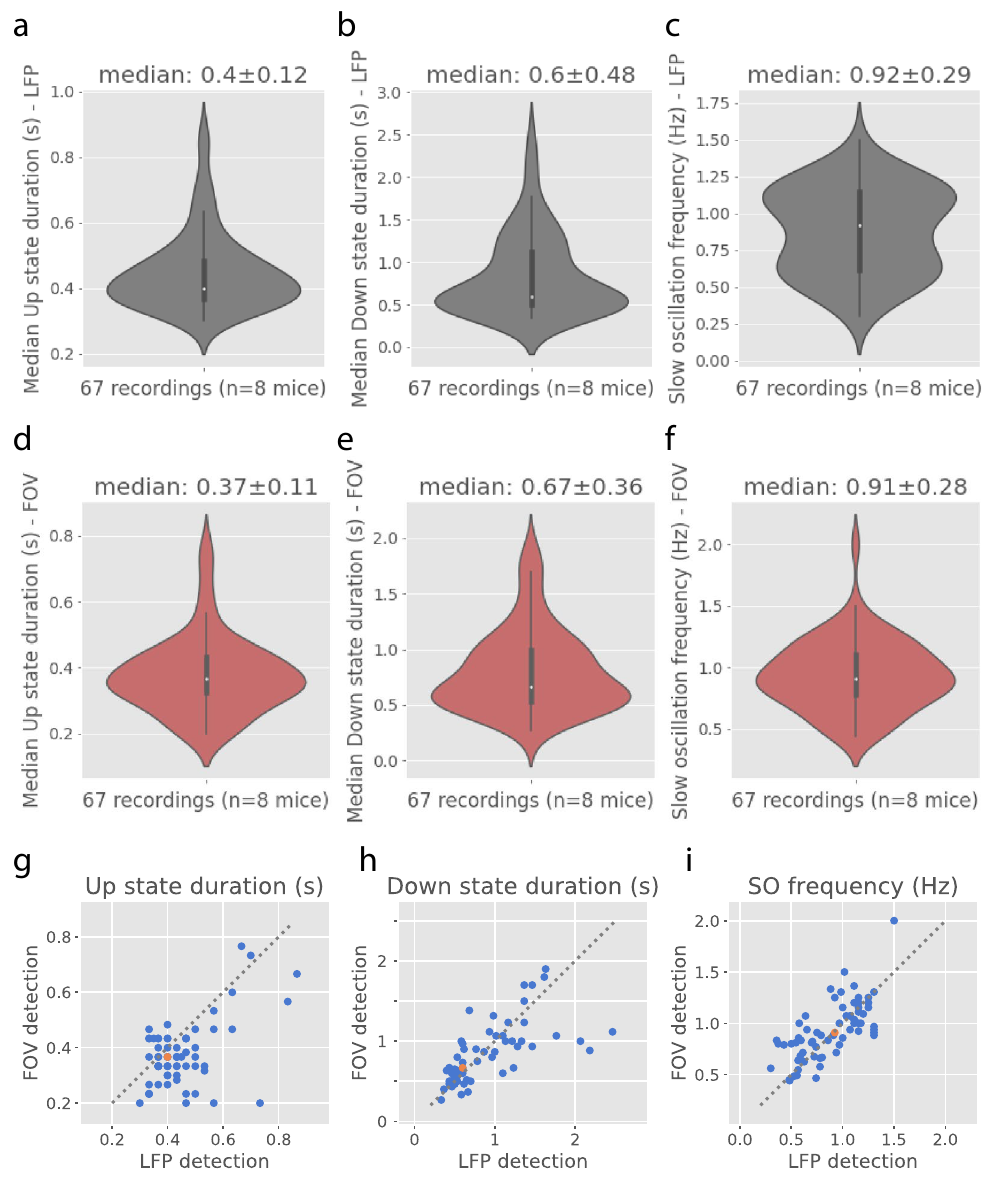
Figure 11. Up and Down state detection from FOV or LFP signals From left to right, Up state duration, Down state duration and frequency of the slow oscillation detected with the LFP signal ( a-c. ) or the FOV signal ( d-f. ). g-i. Correspondance between LFP and FOV measures shown graphically. Each blue dot corresponds to a different recording. The orange dot is the median. The grey dashed line is the model